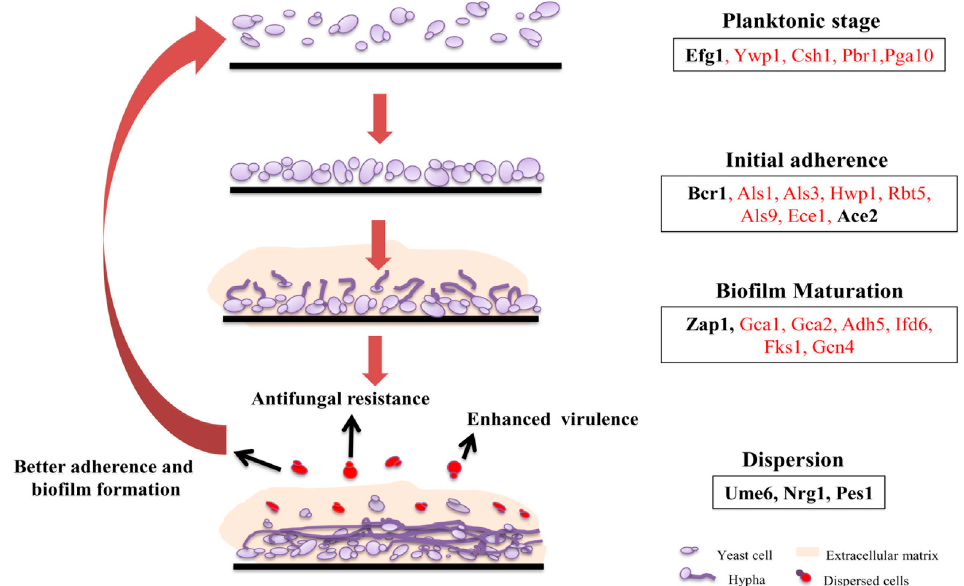
Figure 1. Biofilm development phases in C. albicans . C. albicans biofilm life cycle comprises of attachment of free C. albicans cells to the surface, formation of hyphae, extracellular matrix production, and detachment (dispersion) of cells that can initiate biofilm formation at new sites. For simplicity, few genes including transcription factors (in bold) involved in the indicated stages (as identified in both in vitro and in vivo conditions) are presented in the box. Arrows indicate the properties of the dispersed yeast cells such as enhanced adherence, virulence, and antifungal resistance.